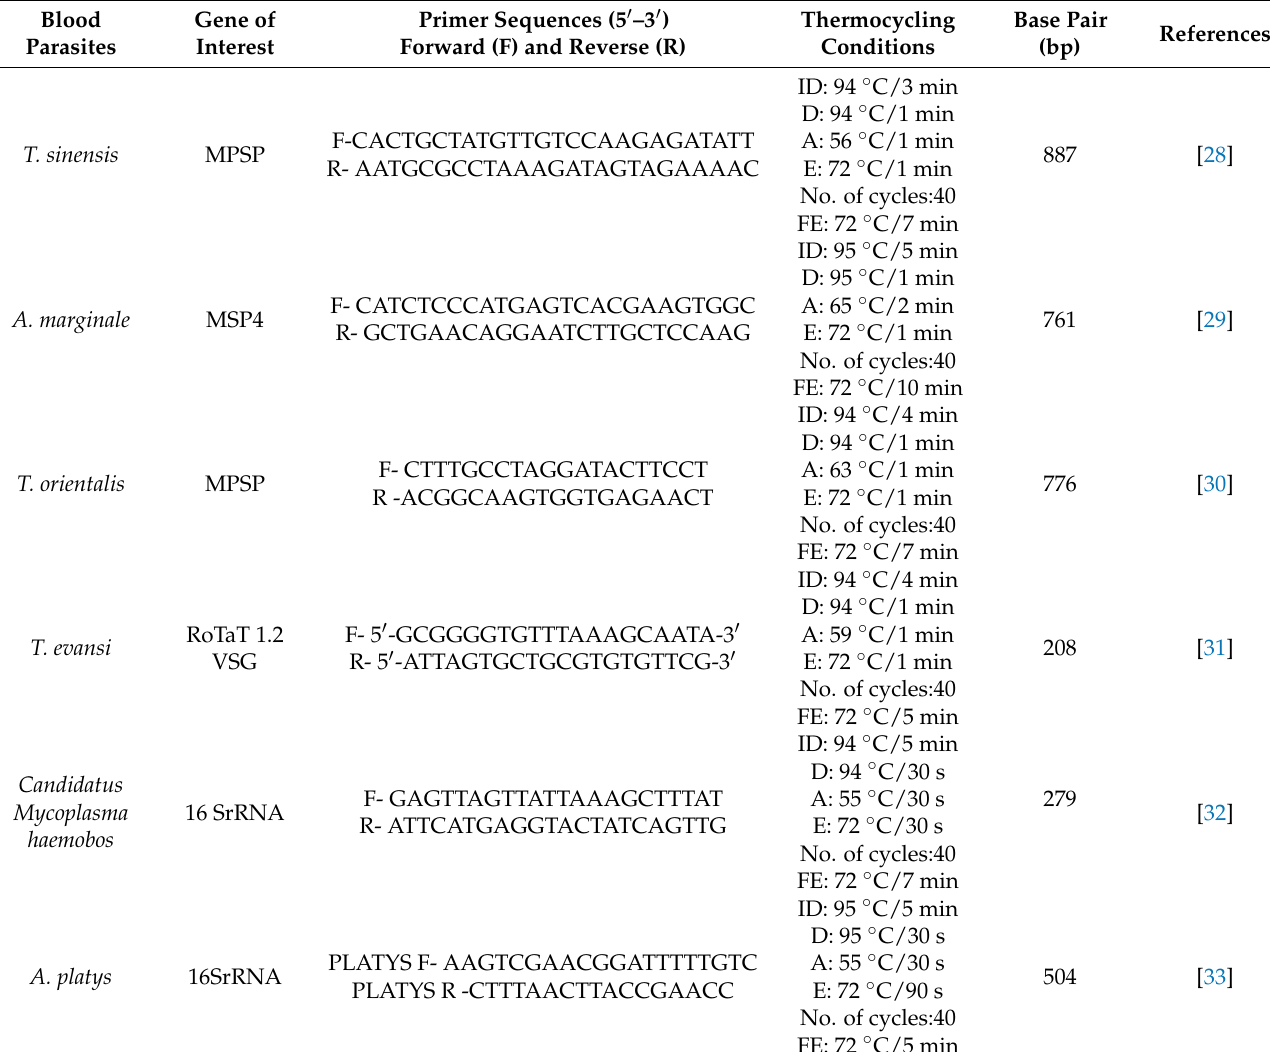
Table 1. Forward and reverse primer sequences and thermal cycling conditions for the PCR detection of cattle blood parasites. Thermal cycling conditions include initial denaturing (ID), denaturing (D), annealing (A), extension (E), and final extension